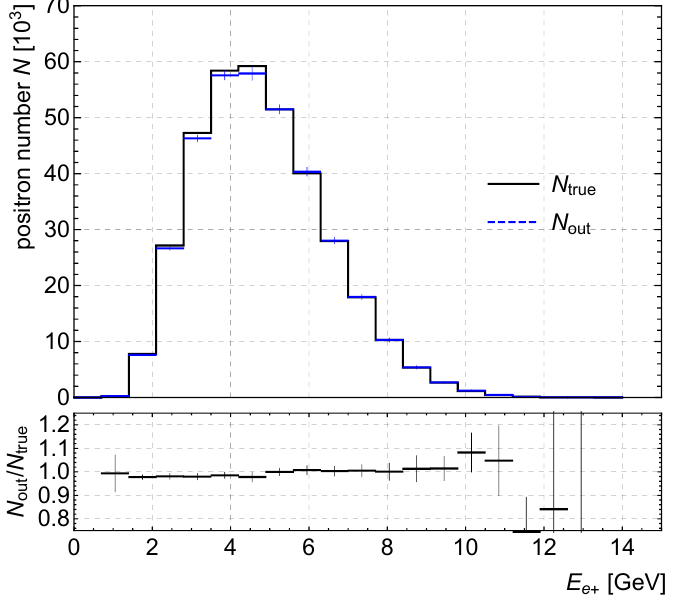
Figure 3. Average CNN output and the true energy spectrum of the 10 runs. Each run contained 350 test